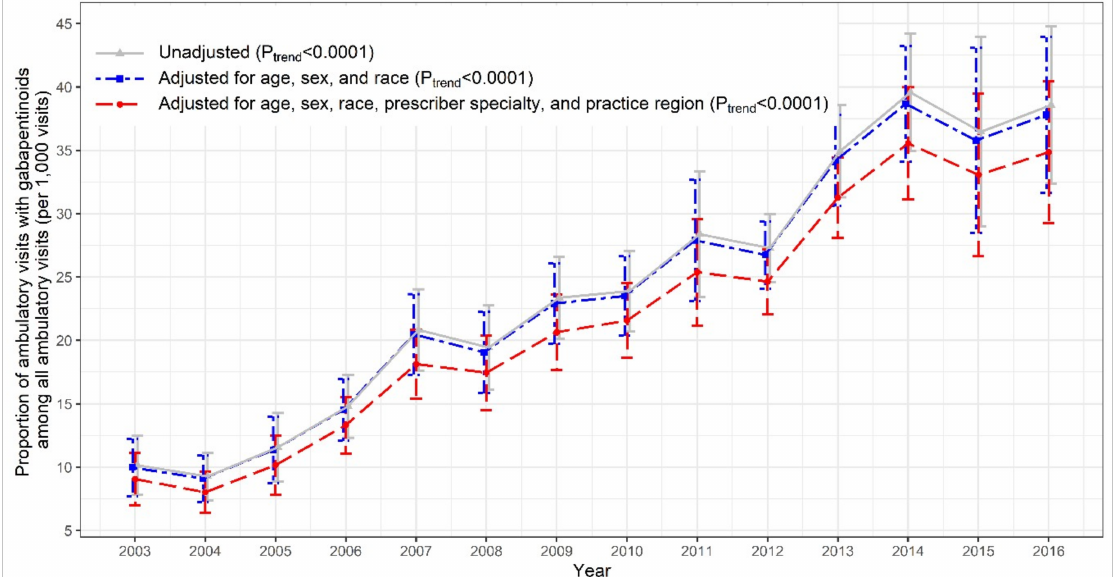
Figure 2. Trends in proportion of ambulatory visits involving gabapentinoids among all US ambulatory care visits: 2003–2016 National Ambulatory Medical Care Survey